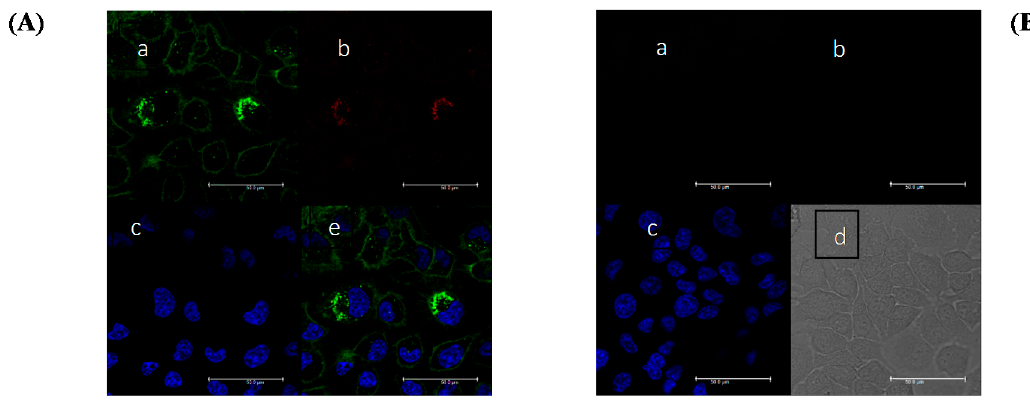
Figure 7. Confocal microscopy analysis of HeLa cells treated with 200 nM Ch(F-TBA-T) (panel ( A )) and untreated (negative control in panel ( B )): (a) FAM channel (green); (b) FRET channel; (c) Hoechst 33342 fluorescence form stained nuclei (blue); as well as (d) bright field image of control and (e) overlay of all images a–c of Ch(F-TBA-T). The experiment details: The probe was added at 200 nM concentration to medium. After leaving overnight, Hoechest 33342 was applied to cell culture at a final concentration of 5 µ g/mL and images was were taken after 15 min. of staining. Before fluorescence imaging, experiment cells were washed twice with PBS and placed in FluoroBright Live Cell Fluorescence Imaging Medium. Fluorescence emission filters: (1) for FAM channel, 510–540 nm, excitation wavelength: 480 nm; (2) for Hoechst channel, 480–500 nm, excitation wavelength: 405